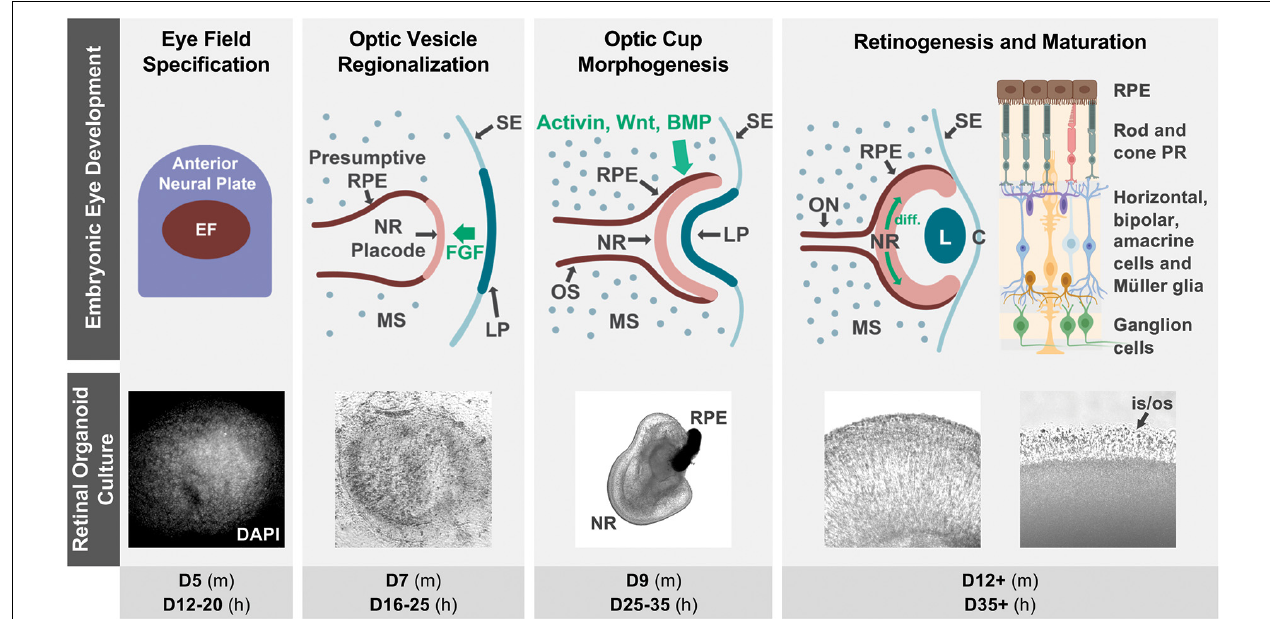
FIGURE 1 | Retinal organoid cultures recapitulate in vivo retinal development. The top row illustrates some of the hallmarks of retinal development in vivo , as well as some key signaling interactions that specify the neural retina and RPE territories in the optic vesicle (notice that interactions contributing to ventral optic vesicle/optic stalk specification are not described, as they are outside of the scope of this review). Fluorescence (DAPI) and bright field micrographs in the middle row show examples of retinal organoid morphology at each of the corresponding developmental stages (retinal organoids were derived from hiPSC using the Zhong et al., 2014 protocol). The bottom row indicates the approximate timing of each developmental step in mouse (m) and human (h) retinal organoid cultures. The retinal diagram was generated using BioRender. Abbreviations: BMP, bone morphogenetic protein; C, cornea; D, days of differentiation; diff., differentiation wave; EF, eye field; FGF, fibroblast growth factor; L, lens; LP, lens placode; MS, mesenchyme; NR, neural retina; ON, optic nerve; OS, optic stalk; is/os, photoreceptor inner and outer segments; PR, photoreceptors; RPE, retinal pigmented epithelium; SE, surface